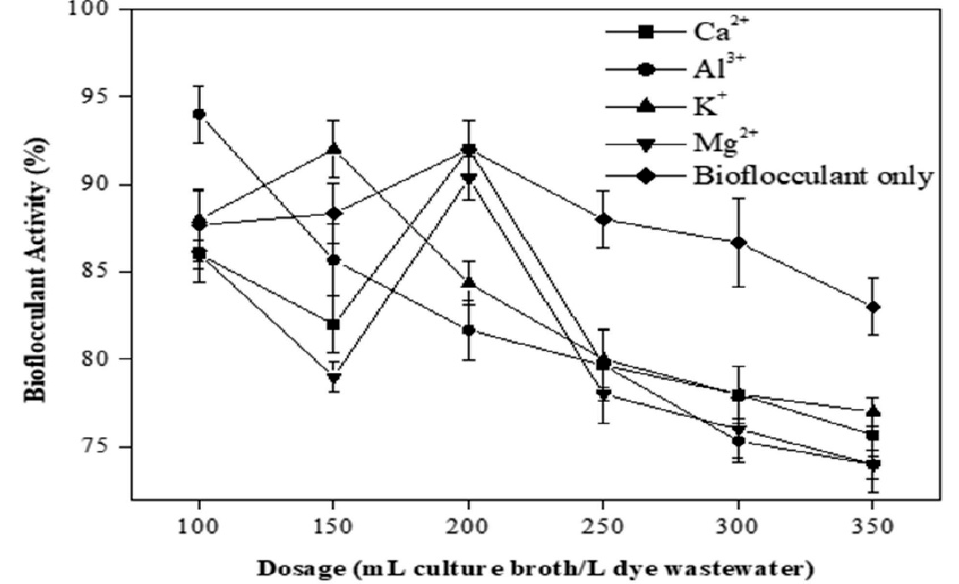
Figure 5. The e ff ect of bioflocculant dosage and cations concentration on the flocculating activity of bioflocculant from Bacillus nitratireducens towards EBT solution. Experiments composition: Experiments composition: 10 mL of EBT (1 g / L) with 390 mL of deionized (D.I), pH 2 adjusted with NaOH (1 M) and / or H 2 SO 4 (0.5 M), di ff erent dosages of nutrient broth containing Bacillus nitratireducens (50, 75, 100, 125, or 150 mL), and 5 mL of salt solution (CaCl 2 , AlCl 3 , KCl, or MgCl 2 ) at a concentration of 10 g / L (except for the experiments with only bioflocculant, with no